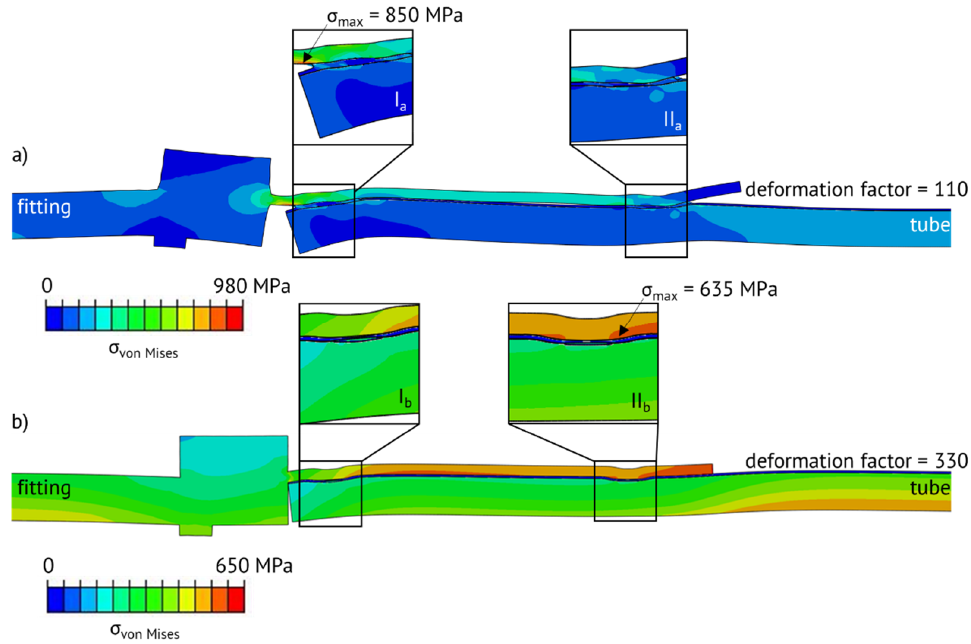
Figure 15. Von Mises stress distribution and deformation behavior of the hybrid joint: ( a ) under 90 kN tensile load and ( b ) under 1050 bar internal pressure with a resulting axial force of 90 kN.